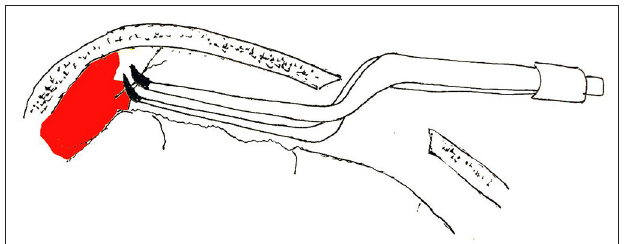
FIGURE 5 | The tip of the bipolar forceps is bent backward to facilitate subdural hemostasis.